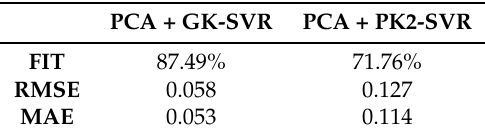
Table 8. SOC estimation results for Route